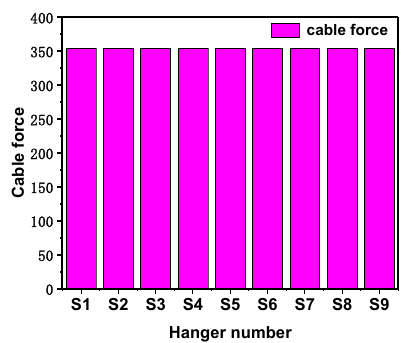
Figure 11. Cable force of south hangers.